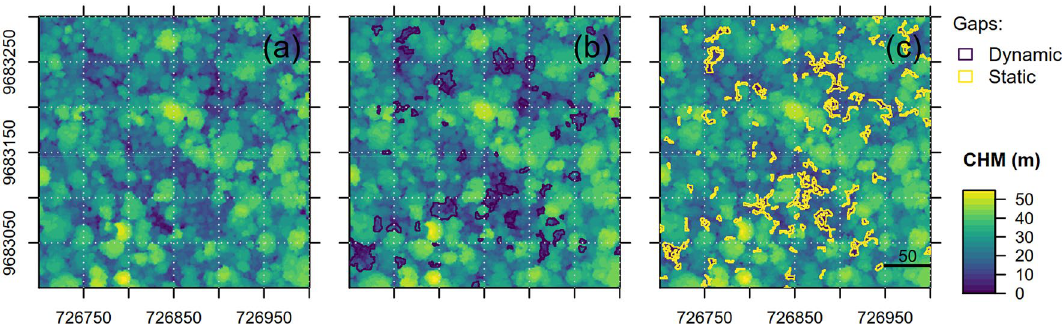
Figure 1. Example of the spatial match between canopy tree mortality (black) and gap delineation (yellow) based on relative height ( RH = 50, W = 5) at the TAP site. The background is a Canopy Height Model (CHM) for the year 2012 in ( a ), and the year 2017 in ( b ) and ( c ). R v4.0.2 was used to plot this figure 32 .